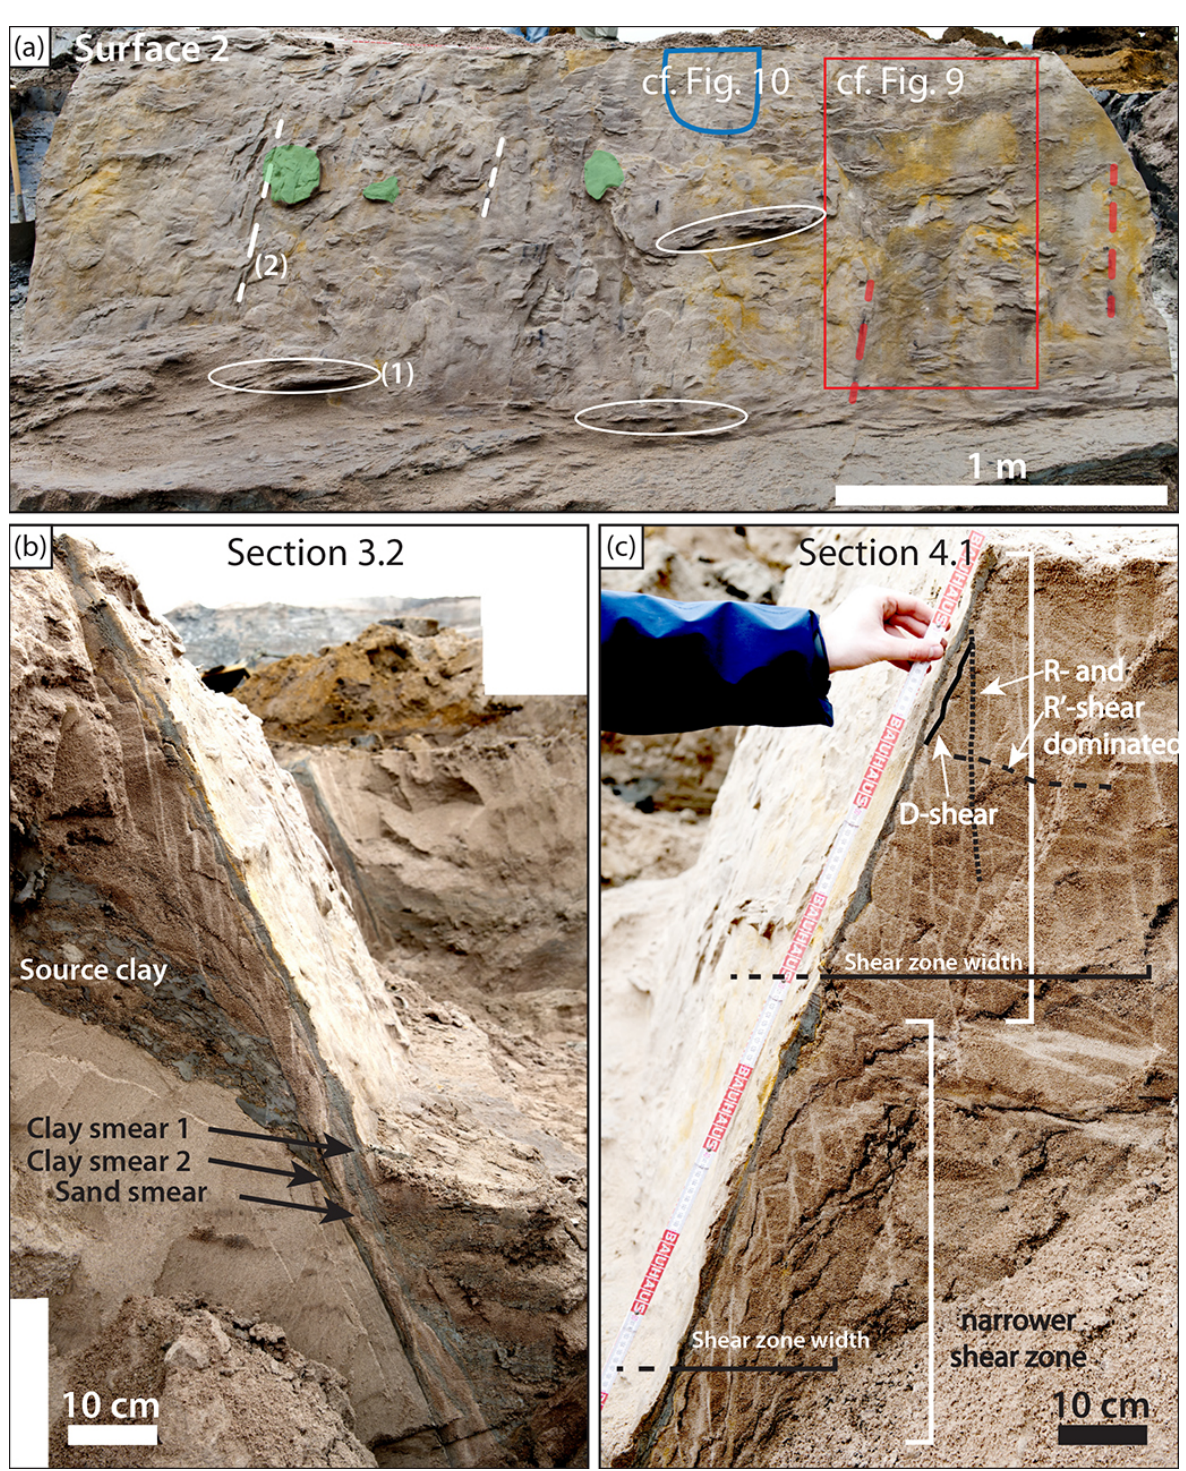
Figure 7. (a) shows the excavated surface 2 and corresponding vertical profiles, (b) 3.2 at the NW side (c) and 4.1 at the SE side. In (b) a continuous sand smear developed between two continuous clay smears and in (c) an intense footwall deformation is reflected in stair-stepping clay smear and strong variations in